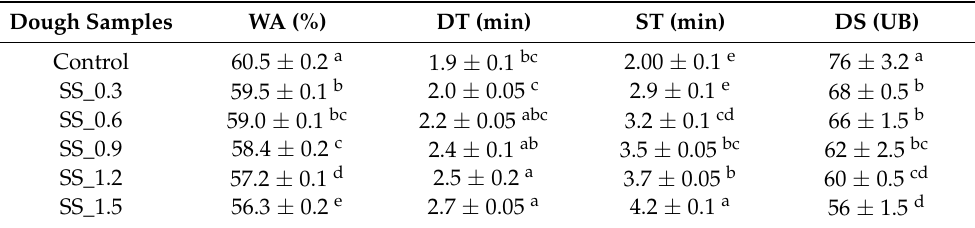
Table 1. Farinograph parameters of the dough samples with different levels of sea salt with low sodium content (SS) additions.